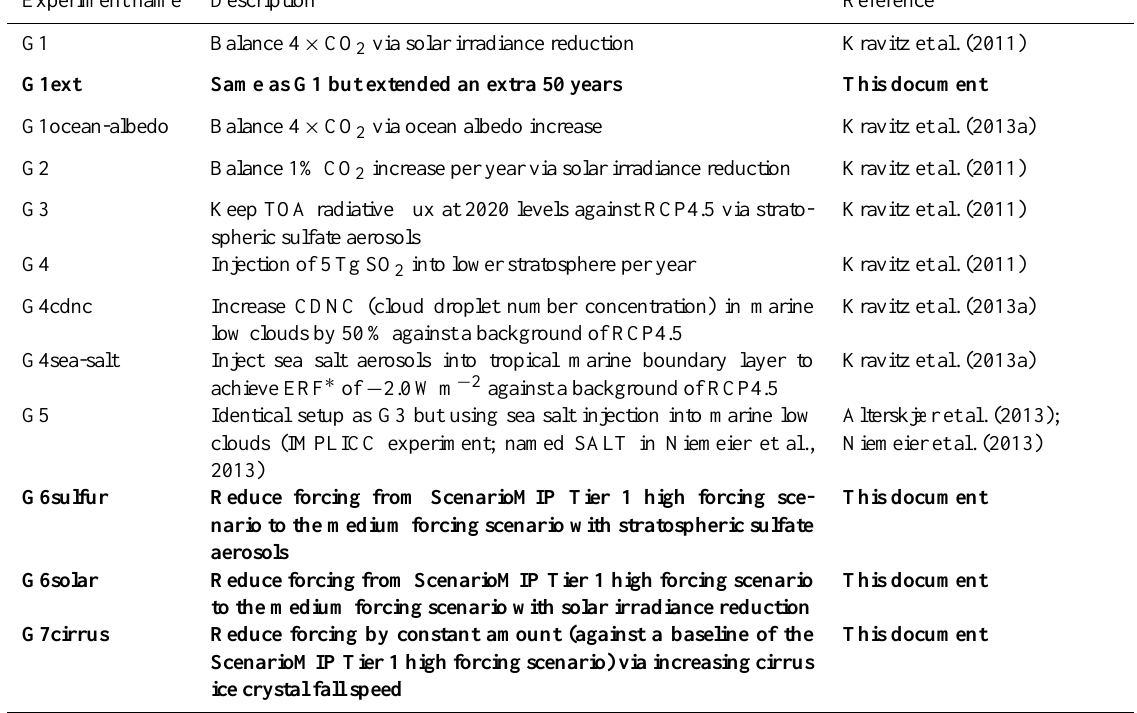
Table 1. All core GeoMIP experiments up to this point, including the additional proposed Tier 1 GeoMIP6 experiments. Only the time-slice Tier 2 experiments are listed in Table 2. For each experiment, the name is given, along with a short description and reference. Newly proposed experiments are printed in boldface. G5 is not a core GeoMIP experiment but is included for